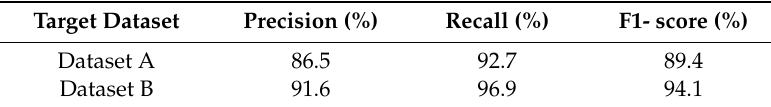
Table 4. Results of two target datasets with Scenario